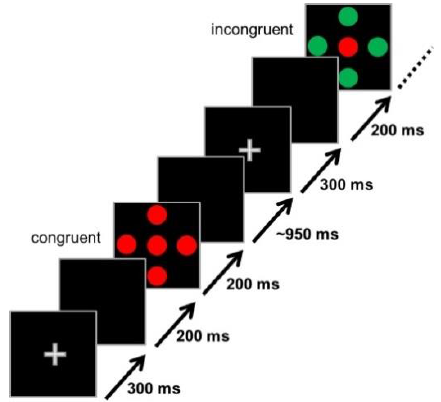
Figure 1. Schematic depiction of the Flanker task used in this study showing an example of a congruent and an incongruent